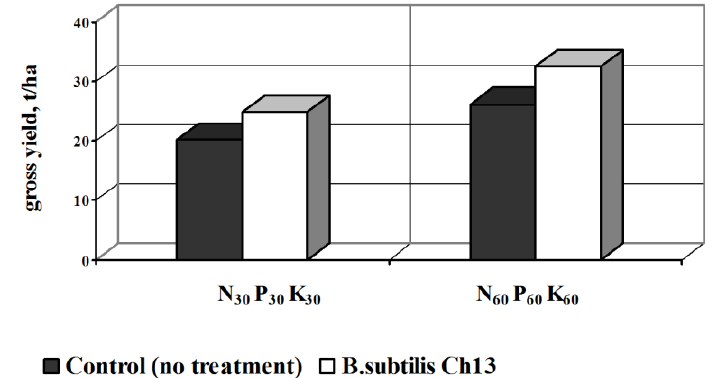
Fig. 1. Yield of Nevsky variety potato after biological treatment at different mineral nutrition